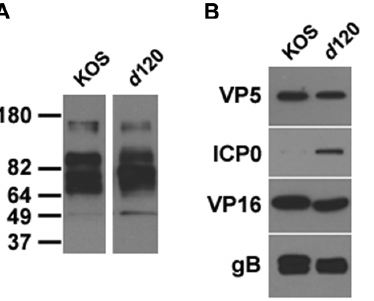
Figure 3. Examination of protein content of HSV-1 d 120 virions. Equivalent VP5 units of HSV-1 KOS or d 120 virions were separated by 4–20% SDS-PAGE. Western blots were probed with anti- HSV polyclonal antibody (A) or MAbs to VP5, ICP0, VP16, or gB (B). Results shown are representative of at least three independent experiments. Molecular weight standards in kiloDaltons are indicated to the left.